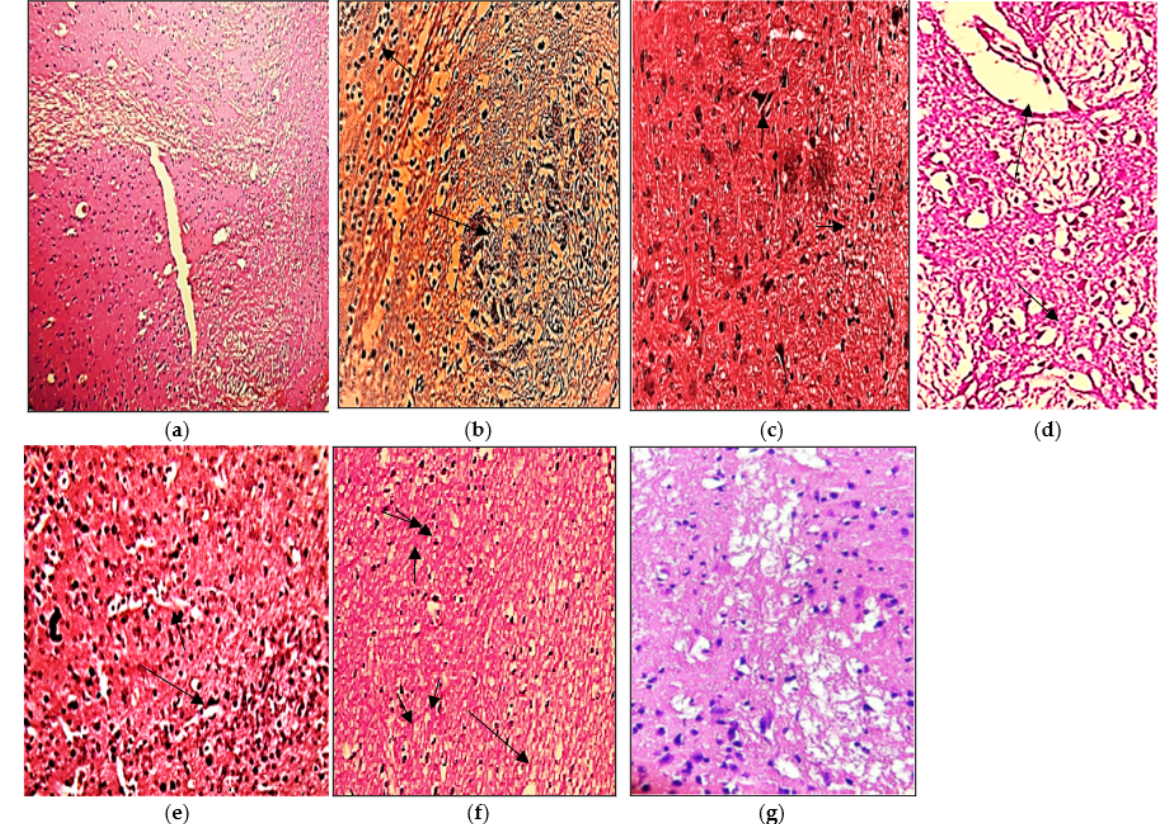
Figure 7. Pictorial presentation of brain H&E stained sections: ( a ) normal control group rat, ( b ) LPS intoxicated rat brain, ( c ) N. hindustana extract-treated group, ( d ) V. negundo treated group, ( e ) A. albiflora ethanolic extract-treated group, ( f ) conjugation of N. hindustana , V. negundo , and A. albiflora treated group, ( g ) brain section of the standard drug group. Objective size is 40×. Arrows represent edematous plaques, sparse lobular lymphoplasmacytic infiltration, and marked demyelination.